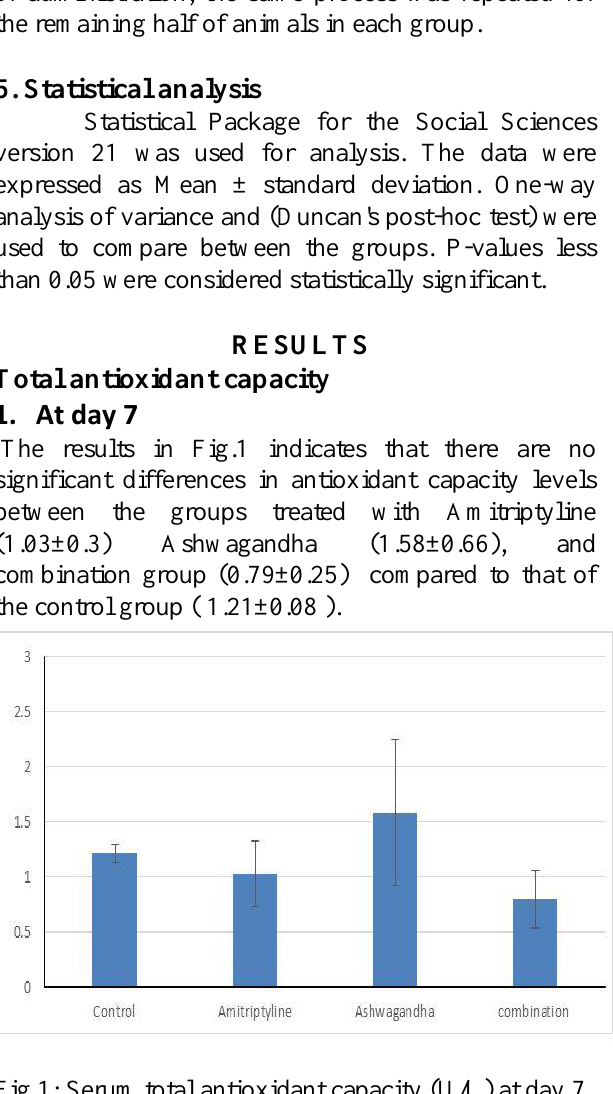
Fig.1: Serum total antioxidant capacity (U/L) at day